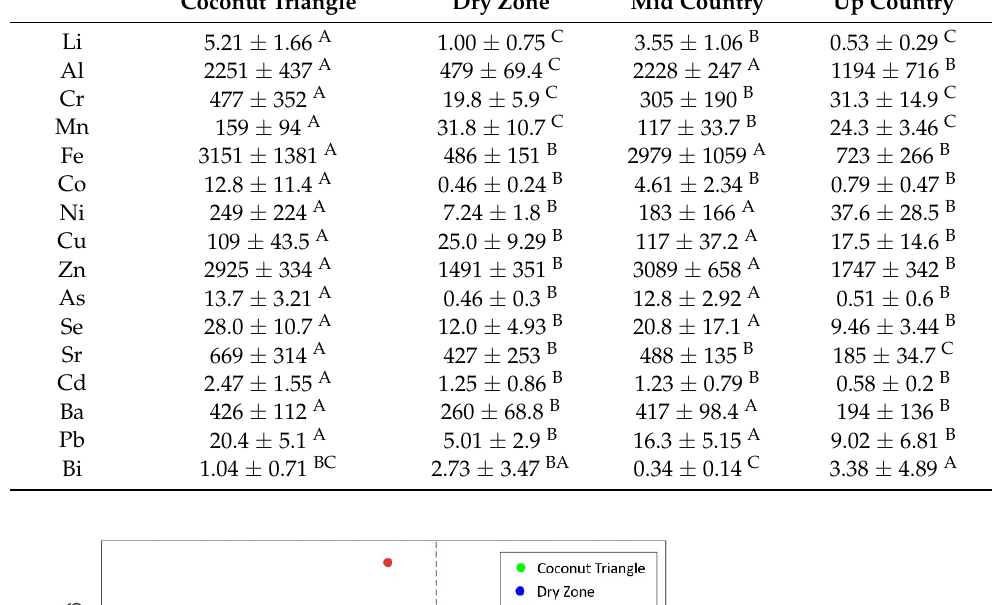
Table 6. Variation of mean values of trace elements in milk samples in each agroclimatic region. Data represent the mean ± standard deviation ( µ g L − 1 ). Values in each row with different superscript letters differ for p < 0.001 (after [20]).